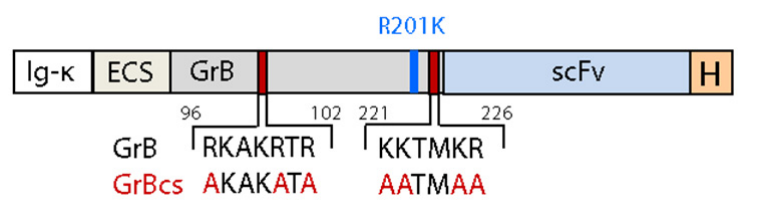
Figure 2. Schematic structure of GrB-based CFP containing the R201K and surface charge (cs)